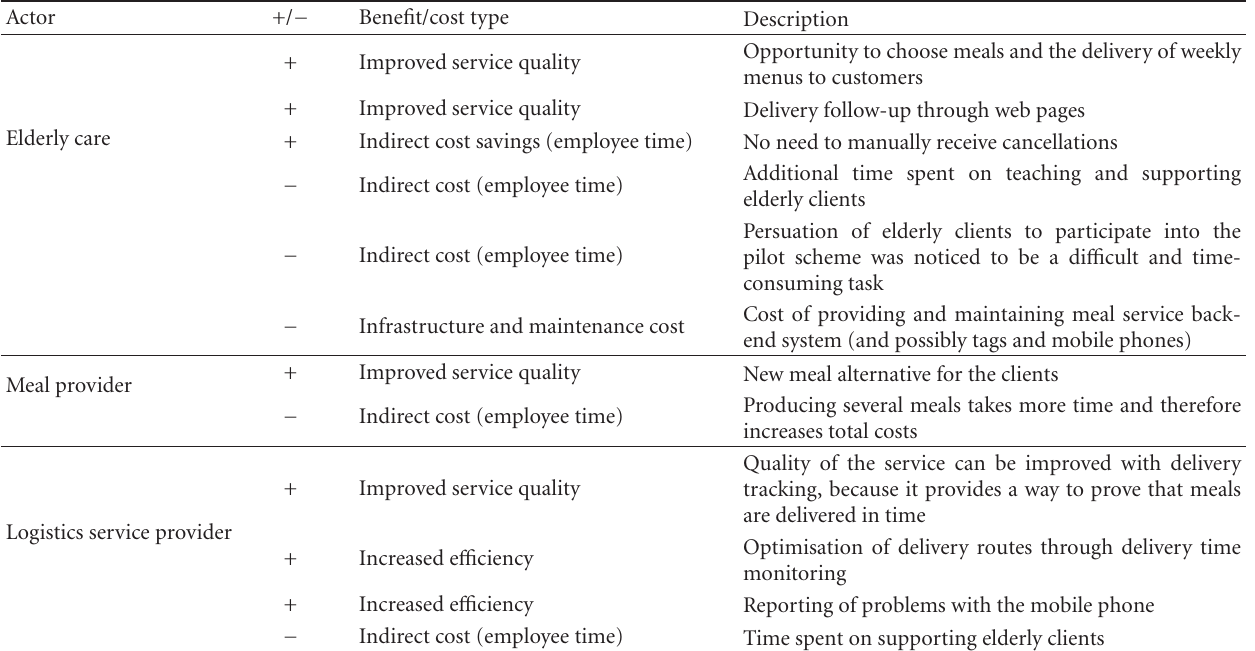
Table 2: Socioeconomic benefits and